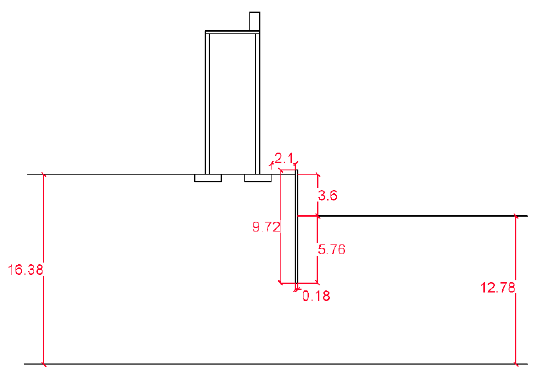
Figure 2. Dimensions of a retaining wall system (unit: m).